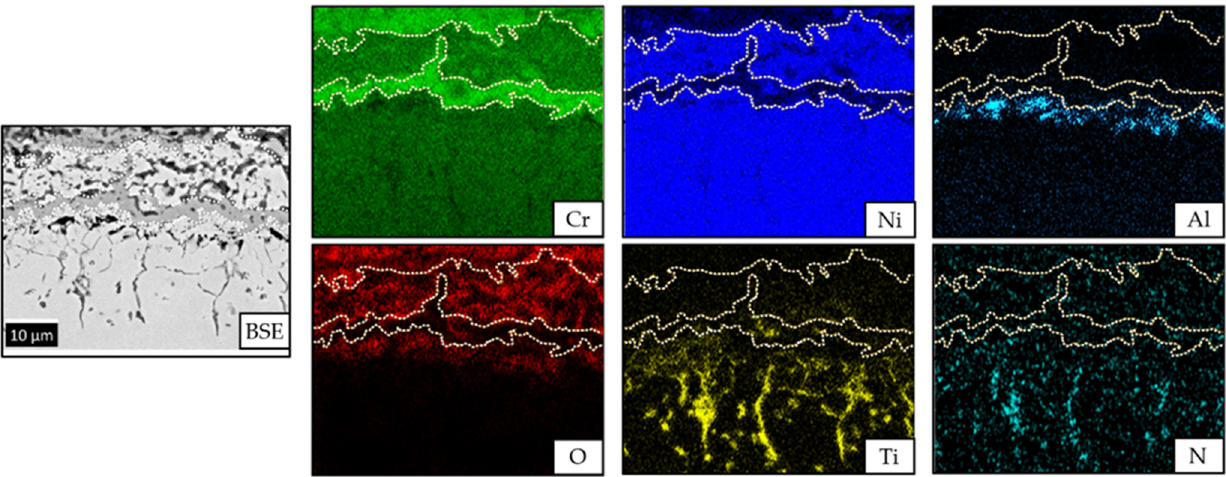
Materials 2021 , 14 , 6040 Figure 5. EDX-Mapping of the isothermally oxidized Cr and Ni reaction layer at the coating-substrate interface region.